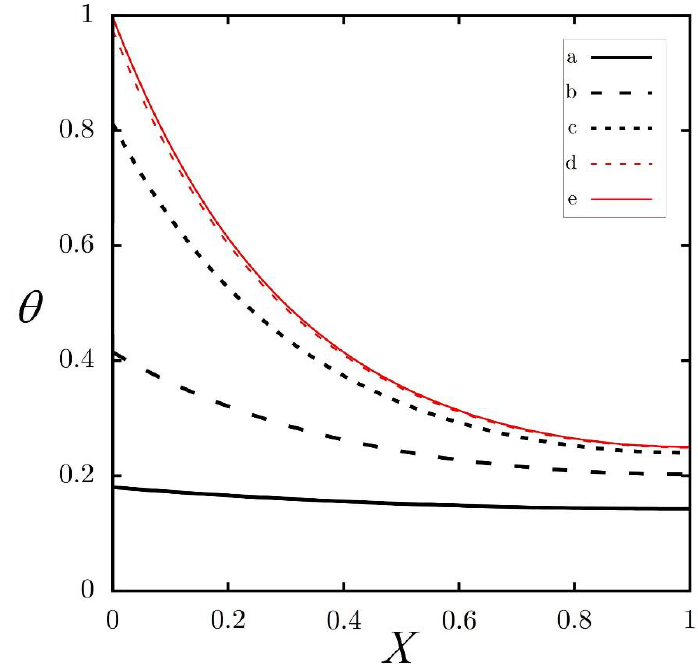
W / k = 50.0 and five values of γ L / k S